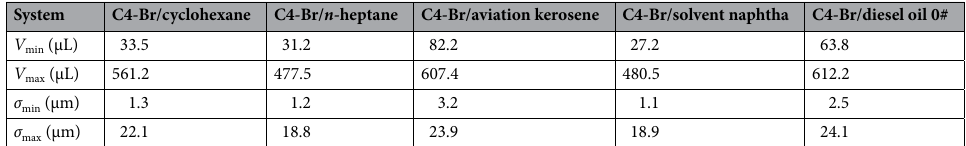
Table 2. The thickness range of aqueous film in the different spreading systems at 25